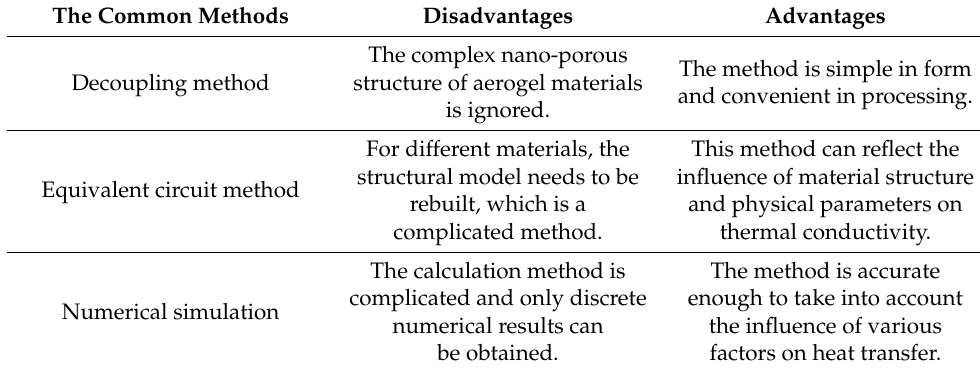
Table 2. The common methods for calculating the effective thermal conductivity. The Common Methods Disadvantages Advantages The complex nano-porous The method is simple in form Decoupling method structure of aerogel materials and convenient in processing. is ignored. This method can reflect the For different materials, the structural model needs to be influence of material structure Equivalent circuit method rebuilt, which is a and physical parameters on complicated method. thermal conductivity. The method is accurate The calculation method is enough to take into account complicated and only discrete Numerical simulation the influence of various numerical results can factors on heat be obtained.